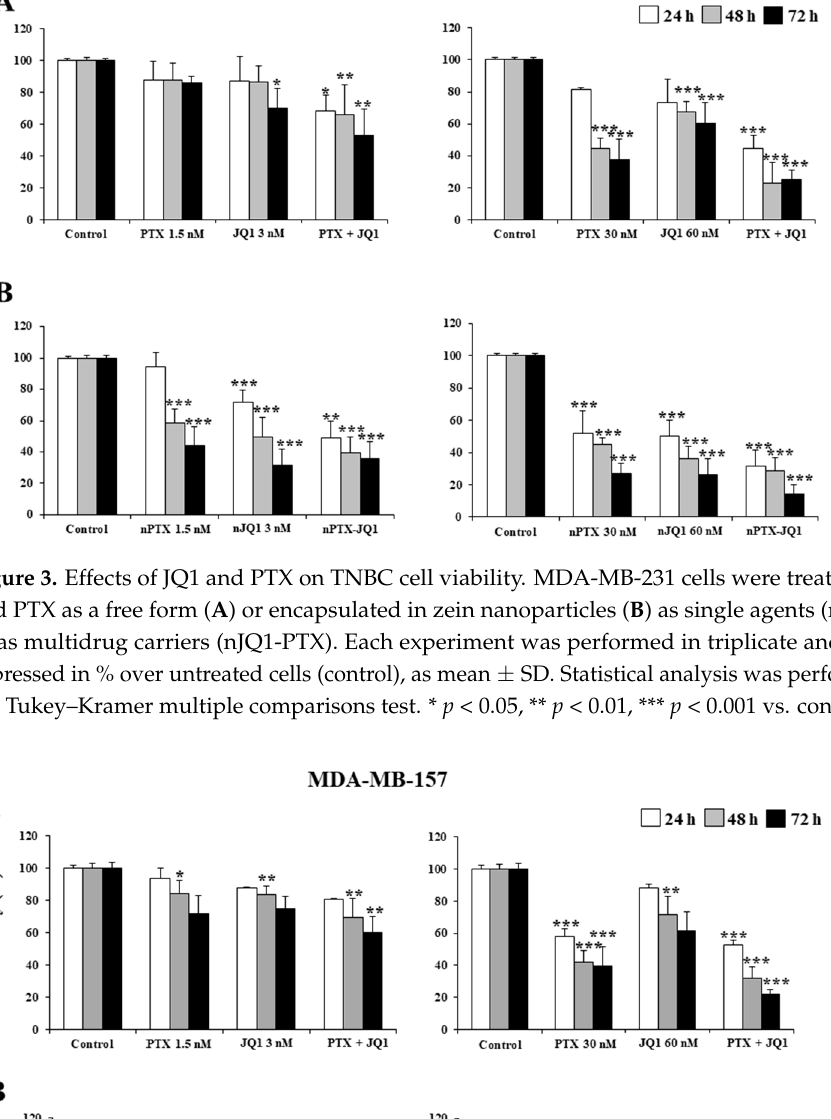
8 of 12 with PTX 30 nM ~70% vs. controls, p < 0.001) (Figure 3A). The nanoencapsulation of the two active compounds within the zein nanoparticles increased their cytotoxicity and the multidrug formulation provided the best results (Figure 3B). In particular, an inhibition of 75% of cell viability was observed on the MDA-MB-231 cells when they were incu-